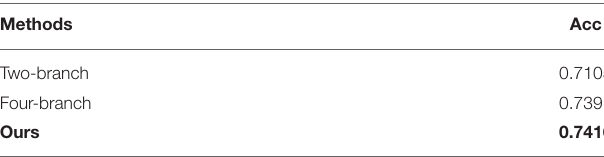
TABLE 4 | Results of ablation experiments for multi-layer and multi-scale on FER2013 dataset.